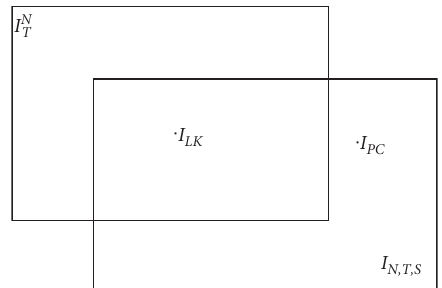
Figure 6: Sets of ( T,N ) - and QL ′